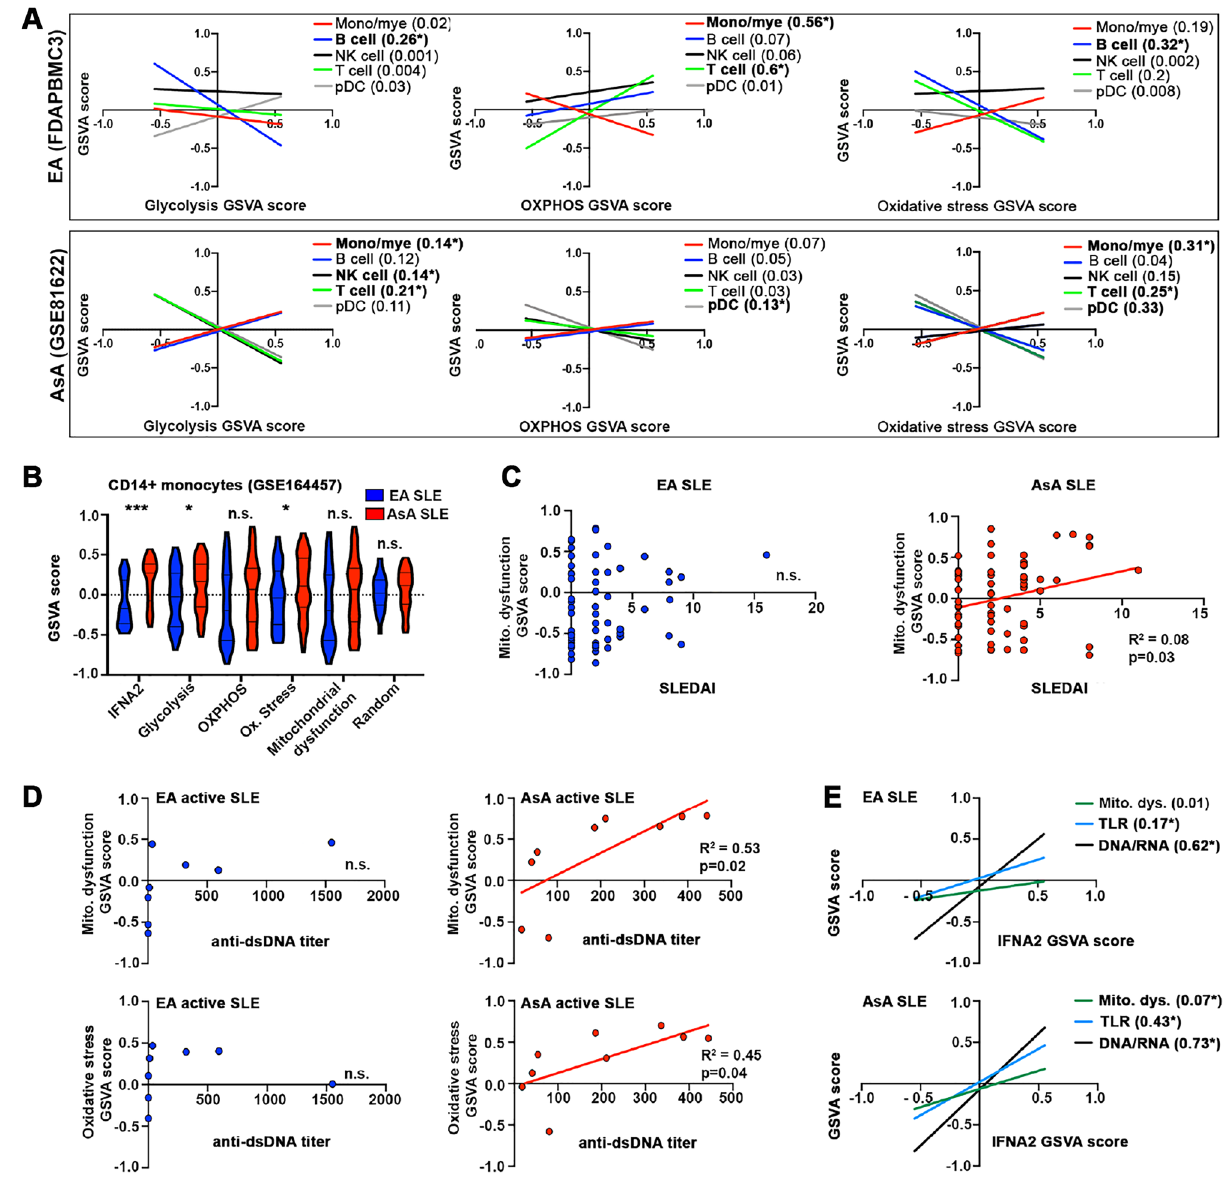
Figure 7. Linear regression to examine the relationship between cell types, biological processes and inflammatory cytokines. ( A ) Linear regression analysis showing the relationship between GSVA scores for glycolysis, oxidative phosphorylation or oxidative stress and individual cell types (pDCs, monocyte/myeloid, B cells, T cells and NK cells) for FDAPBMC1 (EA, upper panels) and GSE81622 (AsA, lower panels). In ( B ), GSVA enrichment scores for the indicated cellular processes were generated for purified CD14+ monocytes from EA and AsA SLE patients (GSE164457). Using GSE164457, linear regression was used to examine the relationship between cellular processes and SLEDAI ( C ), anti-dsDNA titers in active patients (SLEDAI ≥ 6) ( D ) and GSVA scores for IFNA2 ( E ). Categories with linear regression p values < 0.05 are in bold; R 2 predictive values are listed after the GSVA enrichment category. *Asterisks indicate significant relationship between functional categories. N.s., not